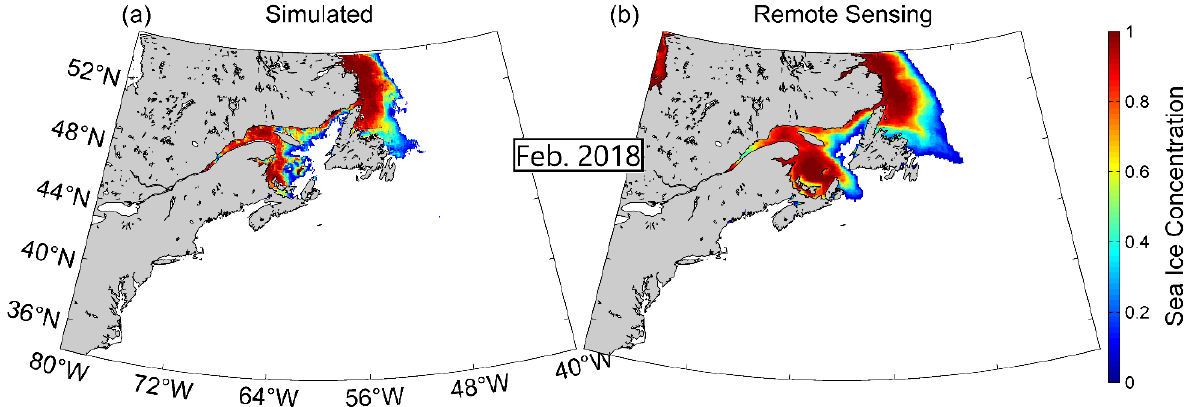
Figure A1. Monthly-mean sea ice concentration (as a fraction of model grid point area) in February 2018 ( a ) produced by NGMS-seCS and ( b ) from the daily GHRSST Level 4 CMC0.1deg Global Foundation Sea Surface Temperature Analysis (GDS version 2) dataset over the domain of submodel L1.